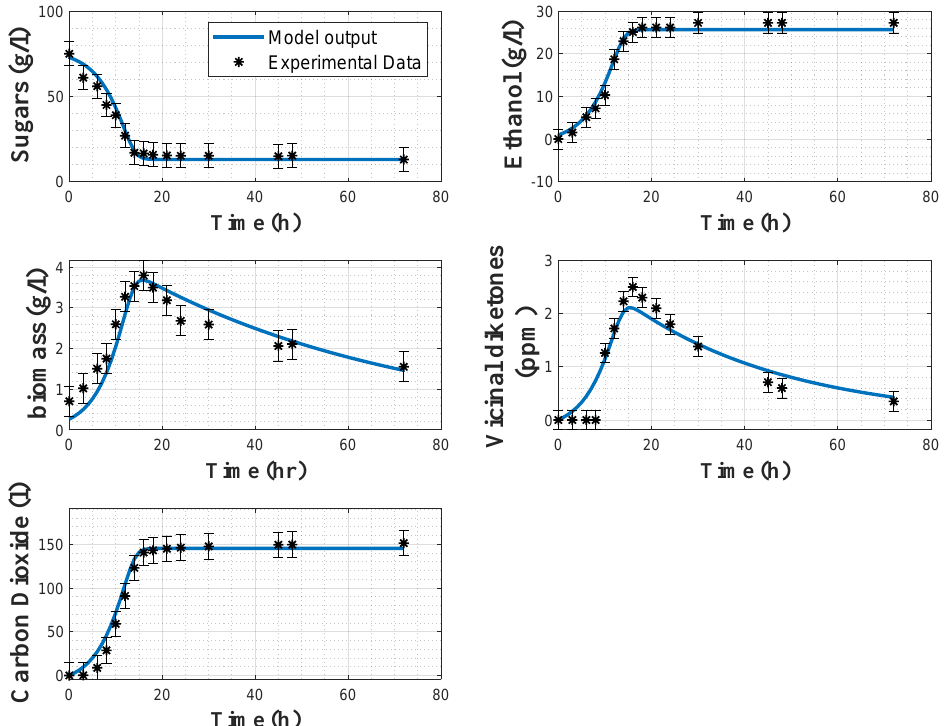
Figure 3. Direct validation of the biomass model with the data from experiment 4. Stars: experimental data. Error bars: 95% confidence intervals. Continuous blue line: model prediction.